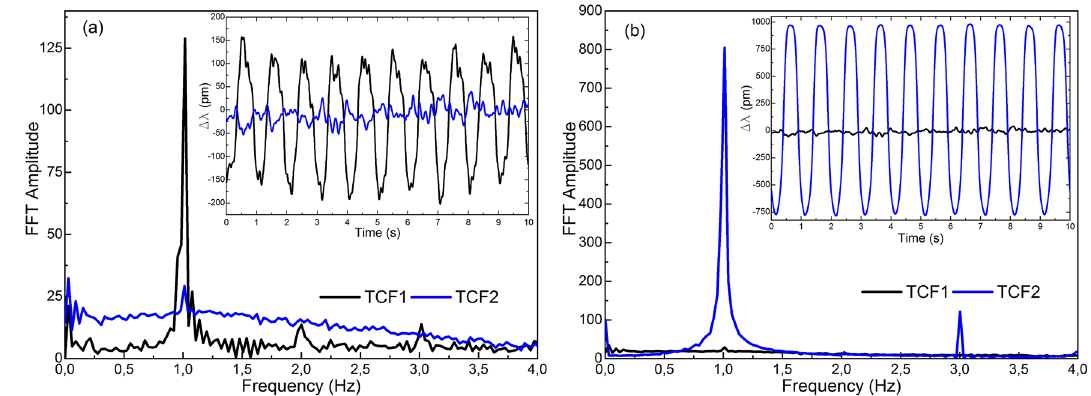
Figure 8. Results in frequency domain when ( a ) TCF1 was vibrating and TCF2 was inactive and ( b ) TCF1 was inactive and TCF2 was vibrating. In the insets, the results in time domain of each case are shown.